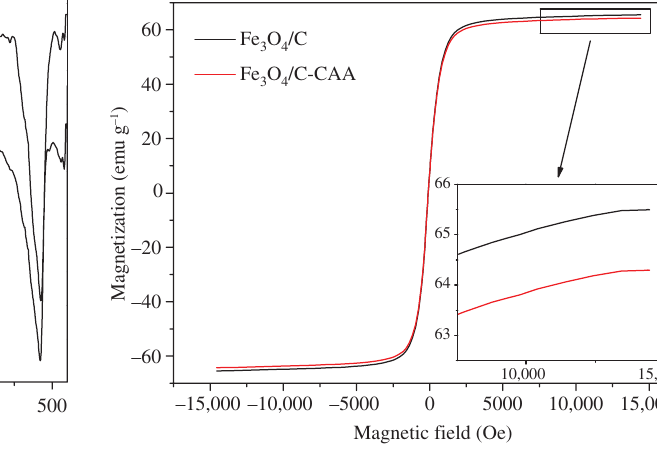
O /C-CAA micro- 3 4